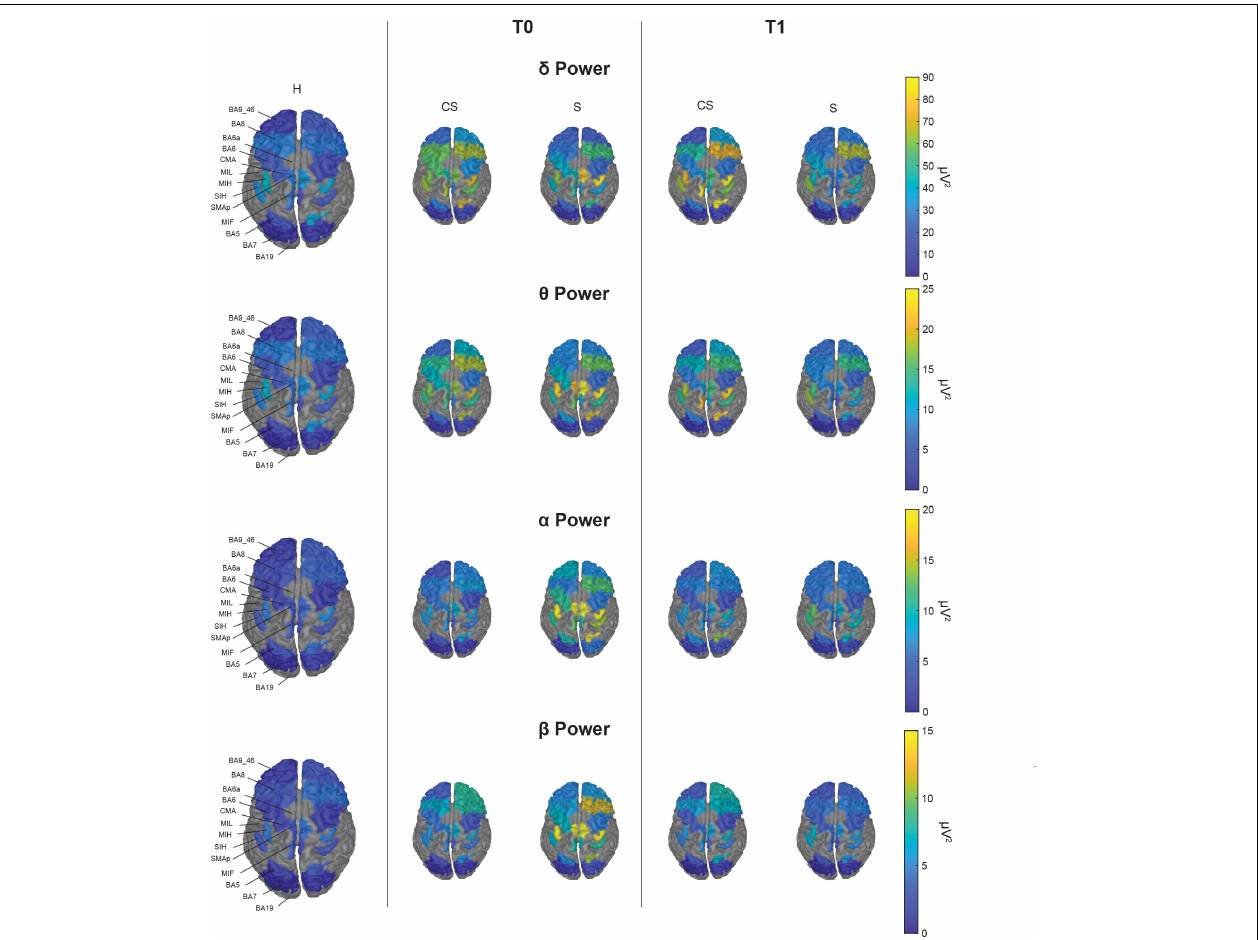
FIGURE 3 | Topographic map of average power for the reconstructed ROIs at T0 (middle panels) and T1 (right panels) in each band of interest for the two group of patients (CS, cortico-subcortical and S, subcortical), compared to healthy subjects (H; left panels). For visualization purposes, ROIs BA19, BA6a, and MIL are not displayed as their mean power exceeds 3 median absolute deviations from the median value of all ROIs. The Kruskal–Wallis test was used to look for differences between the healthy group (H) and the stroke subgroups (CS and S) in each ROI. The significant differences found are shown in Figure 4 .